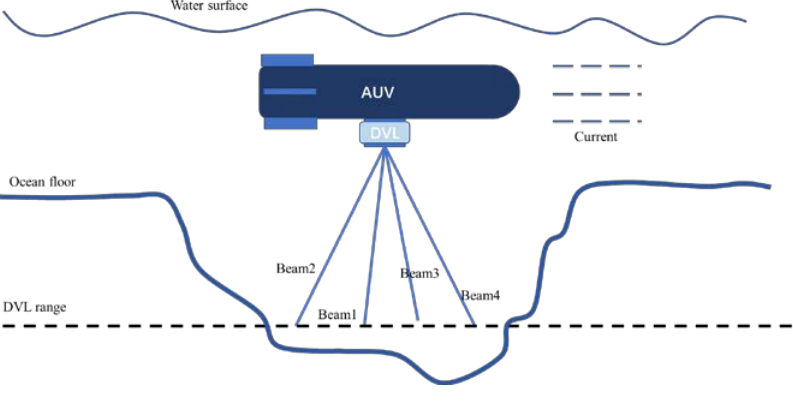
Figure 2. DVL failure condition.